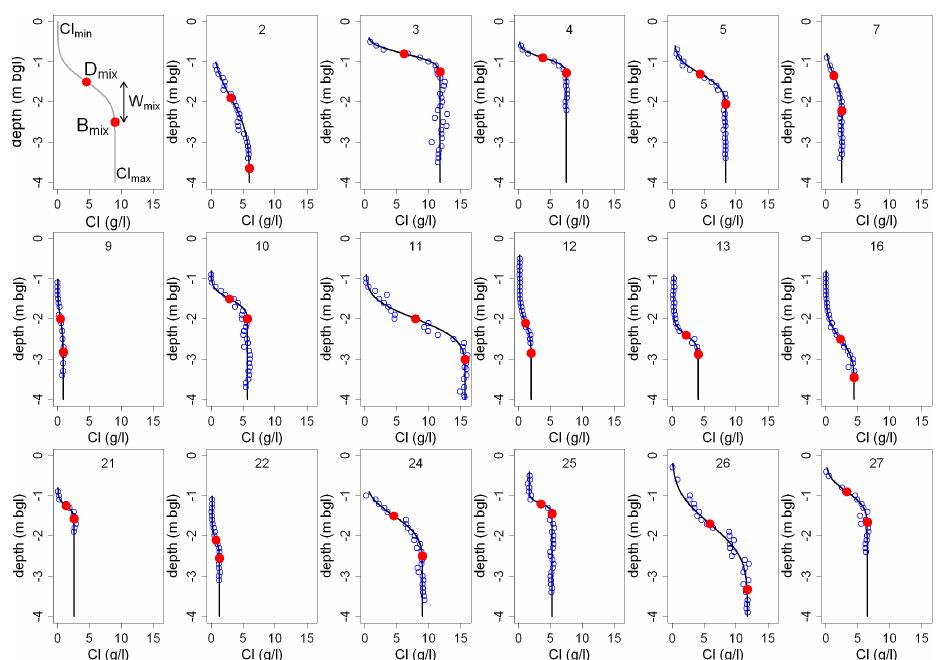
Fig. 6. Characteristics of a rainwater lens, D mix , B mix , W mix , Cl min , Cl max (first plot) and 17 measured salinity profiles with the TEC-probe (blue circles) at different seepage locations in the province of Zeeland (see Fig. 4a for TEC-probe locations). The measured salinity profiles are characterized by the fitted salinity profiles based on spatial moments (black